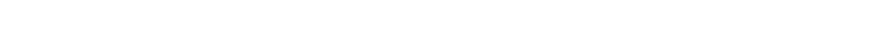
Frontiers in Psychology | Developmental